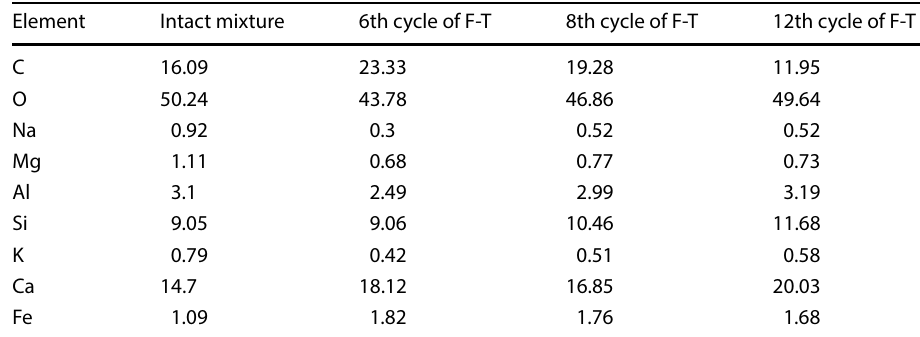
Table 6 The quantitative results of EDX-SEM analysis including the weight percentage of basic elements in the bulk of the CSG mixture with 10% cement encountering various F-T